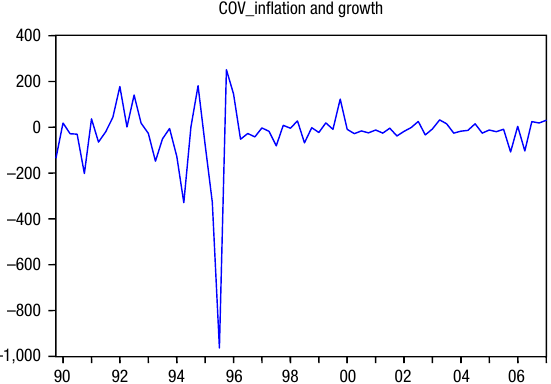
Fig. 2. Estimated conditional covariance for inflation and growth